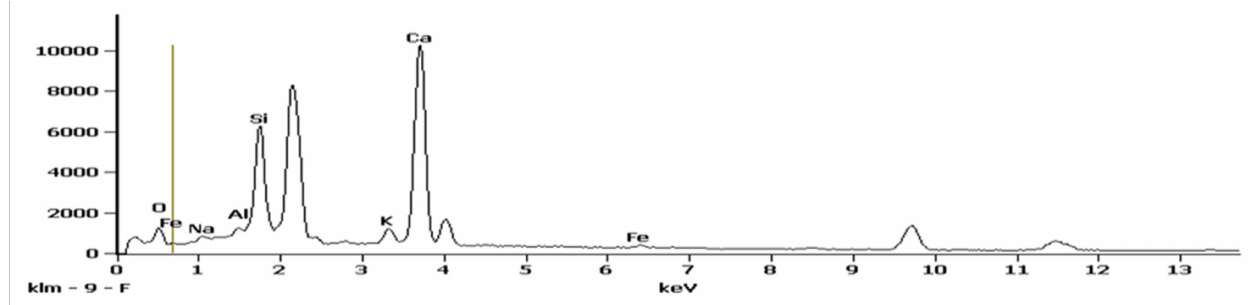
Figure 10. EDS analysis of H-20 indicating a large amount of Ca in the